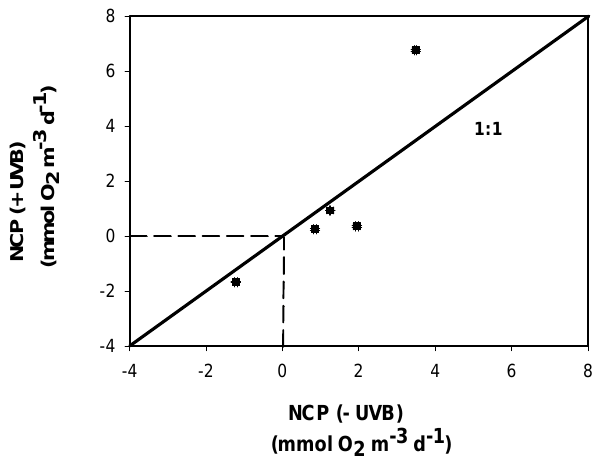
Fig. 6. The relationship between the net community production (NCP) measured in the presence (quartz bottles) and absence (glass bottles) of solar UVB radiation.